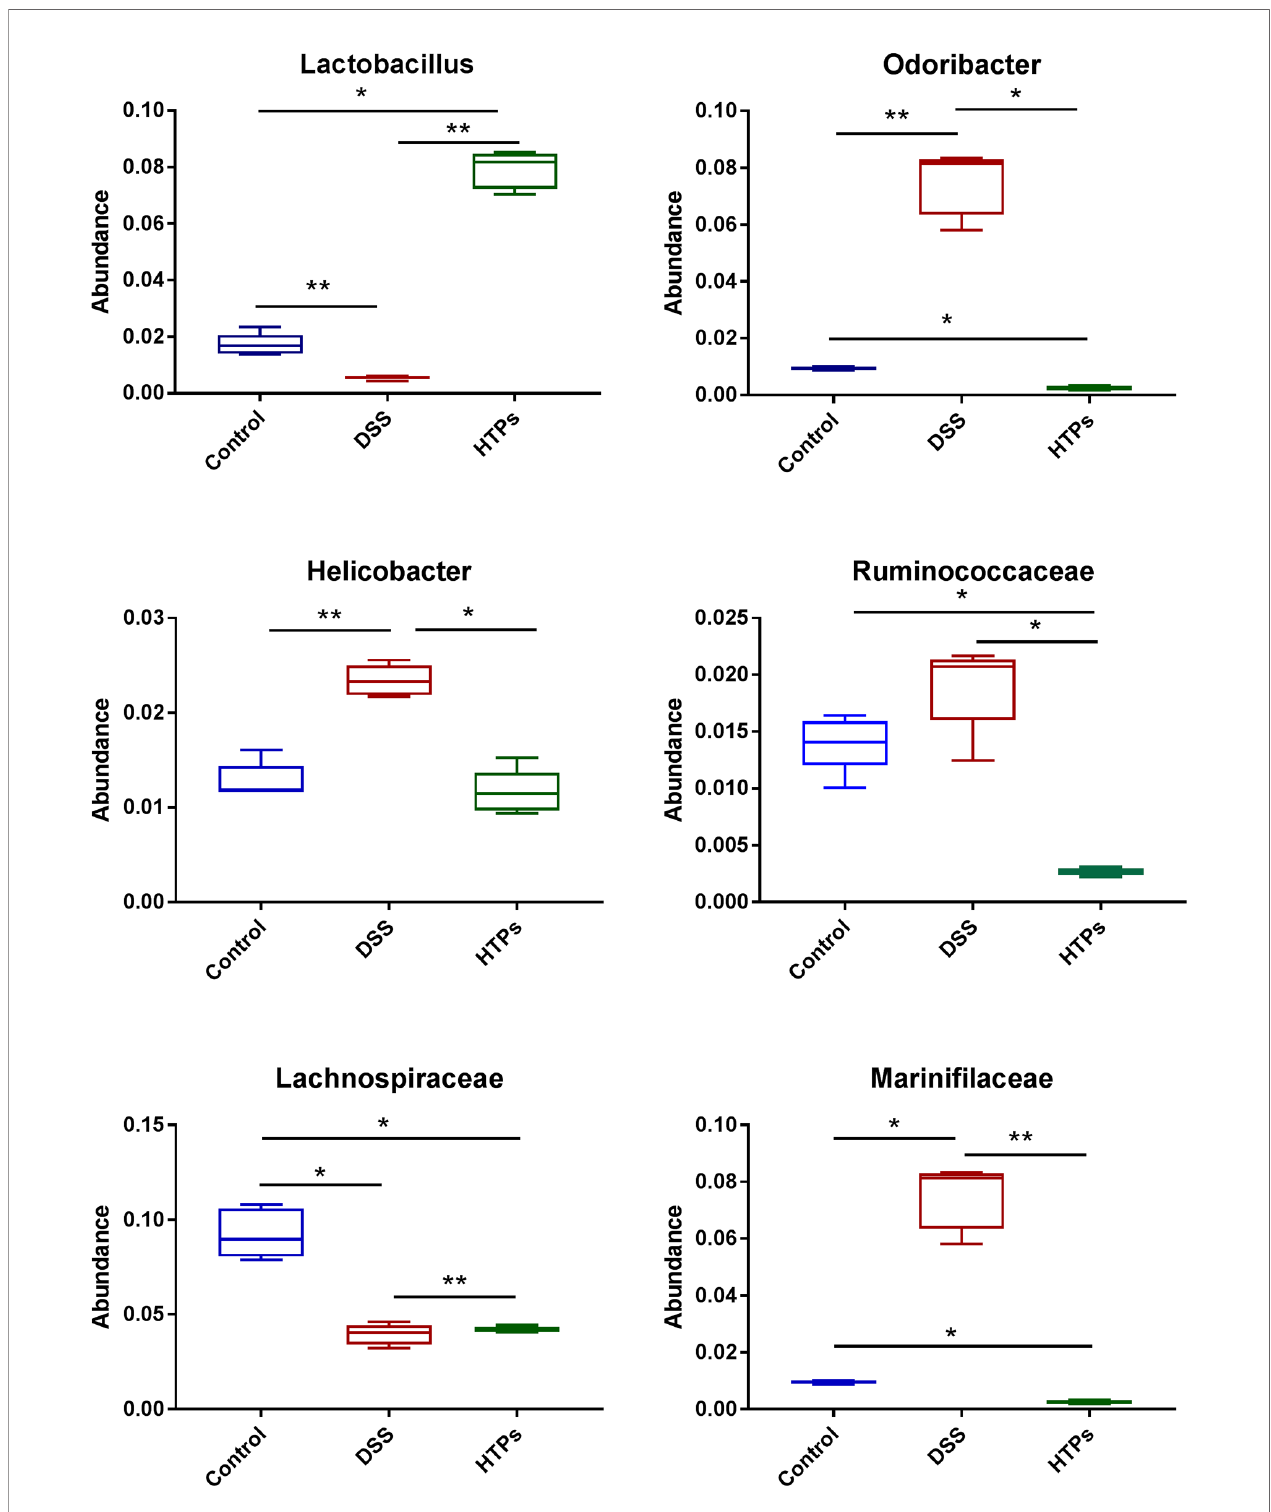
FIGURE 7 | Relative abundances of Lactobacillus, Odoribacter, Helicobacter, Ruminococcaceae, Lactobacillaceae, and Marini fi laceae across each grouped microbiome. All values are represented as mean ± SD ( n = 5).* p < 0.05, ** p <